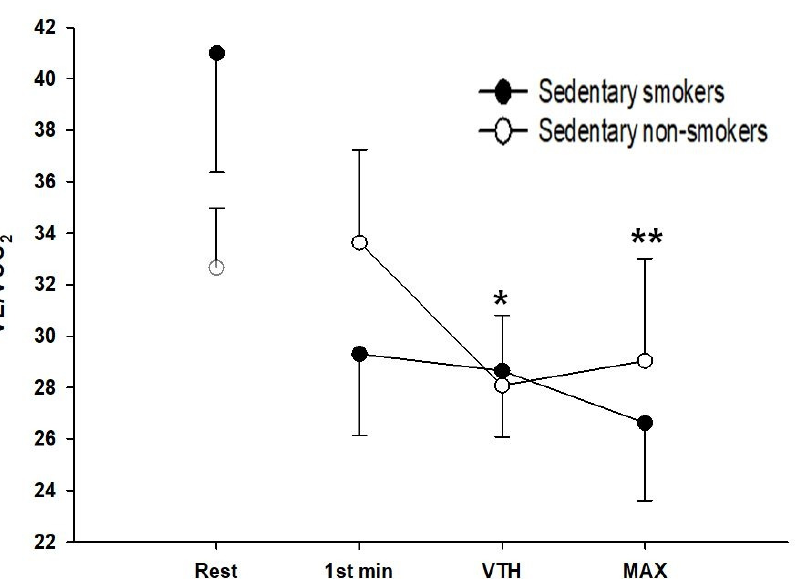
Figure 2. Ventilation equivalents in CO 2 (VE/CO 2 ) in sedentary smokers (black circles) ( n = 25) and sedentary non-smokers (white circles) ( n = 25). t -test for independent samples is used for analysis. Data represented at rest, first minute of exercise, ventilatory threshold, and maximal exercise, respectively; Sedentary smokers vs. sedentary non-smokers: * p < 0.05; ** p < 0.01. The two groups show no significant difference at rest and the first level of exercise. At the ventilatory threshold, VE/VO 2 was significantly lower ( p < 0.05, d = 0.46) while VE/VCO 2 was higher in sedentary young smokers compared to controls ( p < 0.05, d = 0.21). At maximal exercise, VE/VCO 2 was significantly lower in sedentary young smokers than non-smokers ( p < 0.01, d = 0.68). Minute ventilation (VE) is plotted against the work